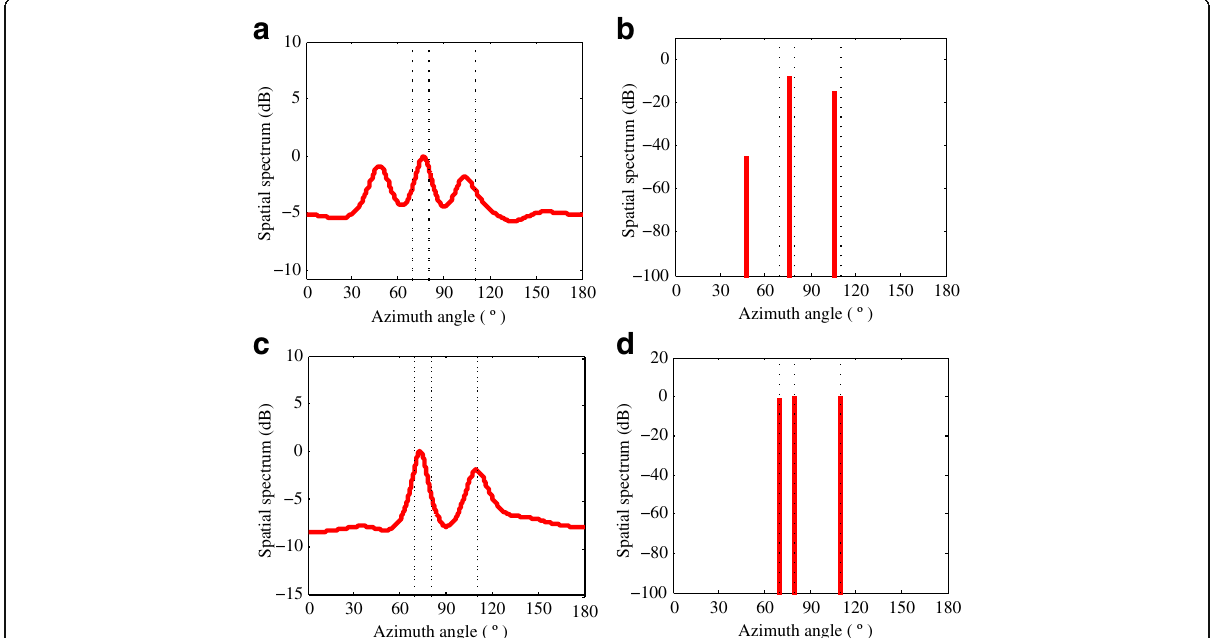
Fig. 3 DOA estimation of different algorithms for coherent wideband LFM signals. a RSS-MUSIC algorithm, b RSS-L1SVD algorithm, c FRFT-SSMUSIC algorithm, and d FDSM-ReFOCUSS algorithm